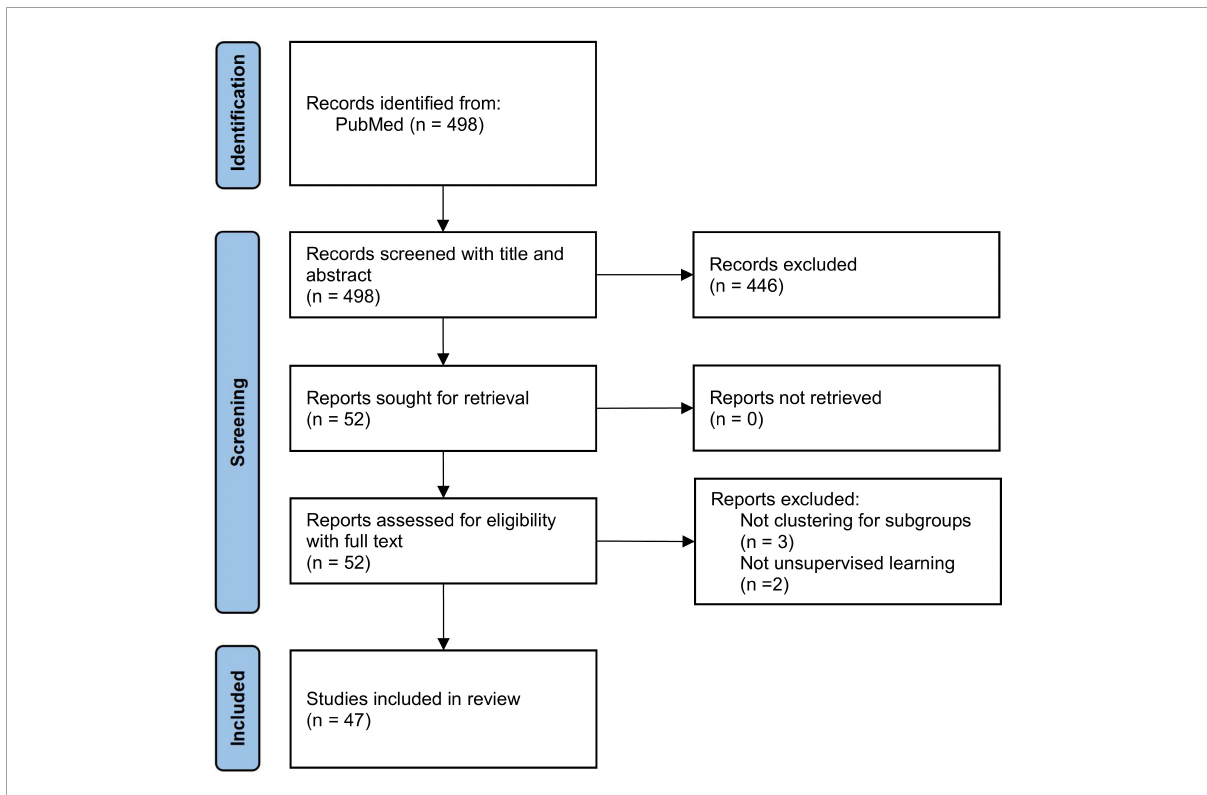
FIGURE1 PRISMA flow diagram for study